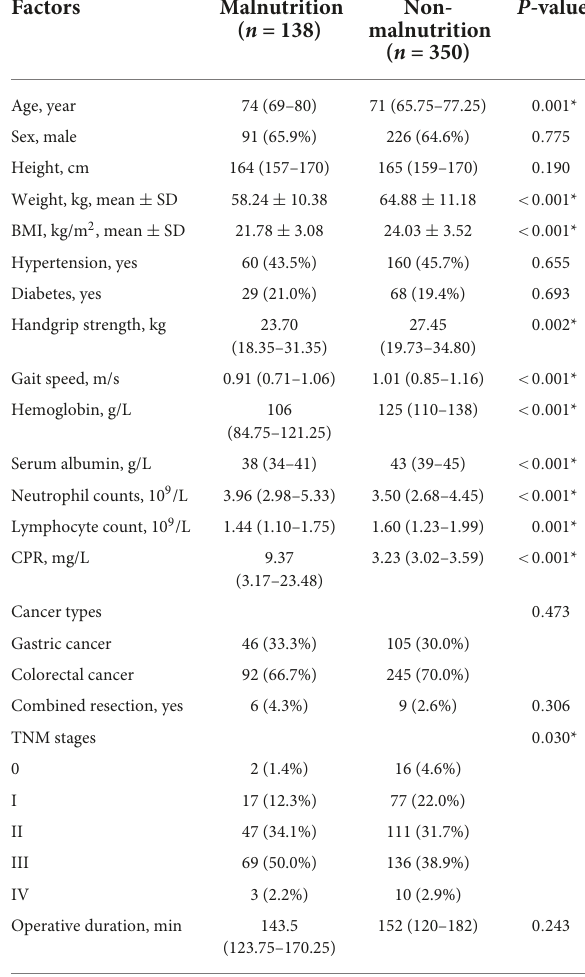
TABLE 1 Baseline characteristics between malnutrition and non-malnutrition